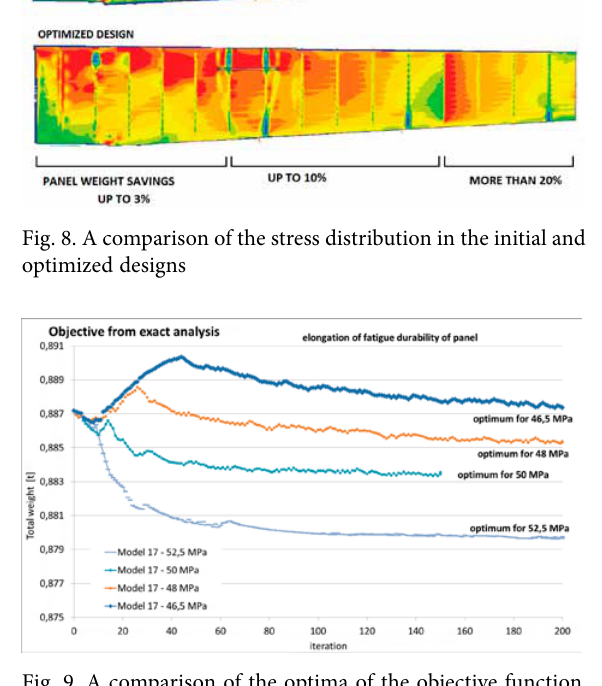
Fig. 9. A comparison of the optima of the objective function for various stress